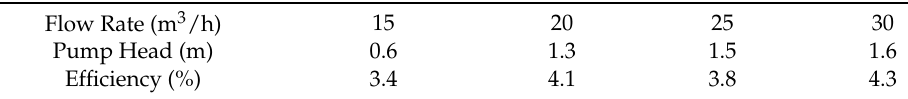
Table 4. Absolute errors between experiment and